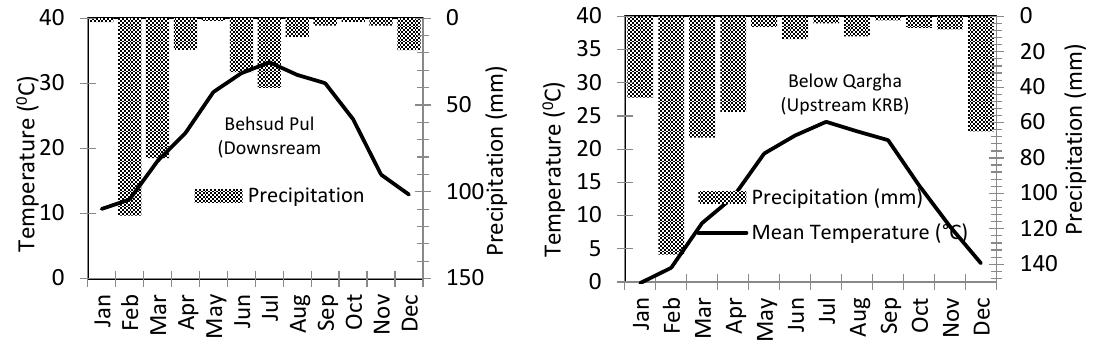
Figure 1. Location of the Kabul River Basin with its sub-basins and provincial.